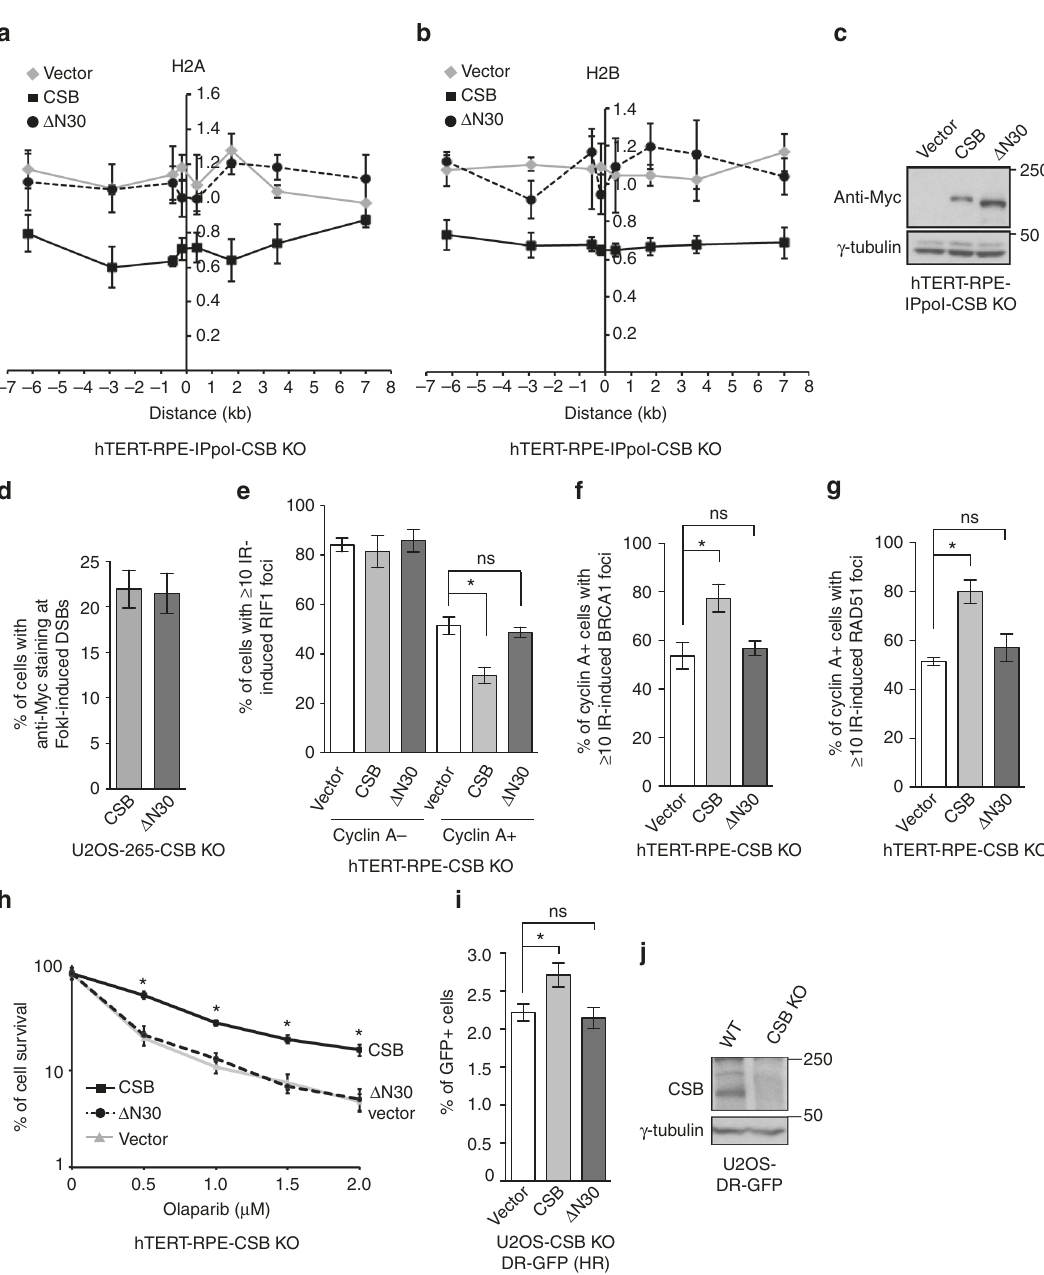
Fig. 6 The N-terminus of CSB mediates its chromatin remodeling activity to repress RIF1 accumulation at sites of DSBs. a Relative occupancy of histone H2A in ddI-PpoI-expressing CSB KO hTERT-RPE cells complemented with various alleles as indicated. Both x - and y -axes are as described in Fig. 5a. SEM from three independent experiments are indicated. b Relative occupancy of histone H2B in ddI-PpoI-expressing CSB KO hTERT-RPE cells complemented with various alleles as indicated. Both x - and y -axes are as described in Fig. 5a. SEM from three independent experiments are indicated. c Western analysis of hTERT-RPE-IPpoI-CSB KO cells expressing various alleles as indicated. d Quanti fi cation of the percentage of Myc-CSB and Myc-CSB- Δ N30-expressing U2OS-265 cells exhibiting anti-Myc staining at FokI-induced DSBs. A total of 250 cells positive for anti-Myc staining were scored for each independent experiment in a blind manner. SDs from three independent experiments are indicated. e Quanti fi cation of the percentage of cyclin A- and cyclin A + cells with 10 or more IR-induced RIF1 foci. hTERT-RPE CSB KO cells stably expressing various alleles as indicated were treated with 2 Gy IR and fi xed 1 h post IR. A total of 500 – 550 cells were scored for each independent experiment in a blind manner. SDs from three independent experiments are indicated. * P < 0.05. ns: P > 0.05 (Student t test). f Quanti fi cation of the percentage of cyclin A + cells with ≥ 10 IR-induced BRCA1 foci. Scoring was done as in e . SDs from three independent experiments are indicated. * P < 0.05. ns: P > 0.05 (Student t test). g Quanti fi cation of the percentage of cyclin A + cells with 10 or more IR-induced RAD51 foci. hTERT-RPE CSB KO cells stably expressing various alleles as indicated were treated with 2 Gy IR and fi xed 4 h post IR. Scoring was done as in e . SDs from three independent experiments are indicated. * P < 0.05. ns: P > 0.05 (Student t test). h Clonogenic survival assays. SDs from three independent experiments are indicated. * P < 0.05 (Student t test) for comparison between CSB and Δ N30. i HR-mediated repair. SDs from three independent experiments are indicated. * P < 0.05. ns: P > 0.05 (Student t test). j Western analysis of U2OS-DR-GFP parental and CSB KO